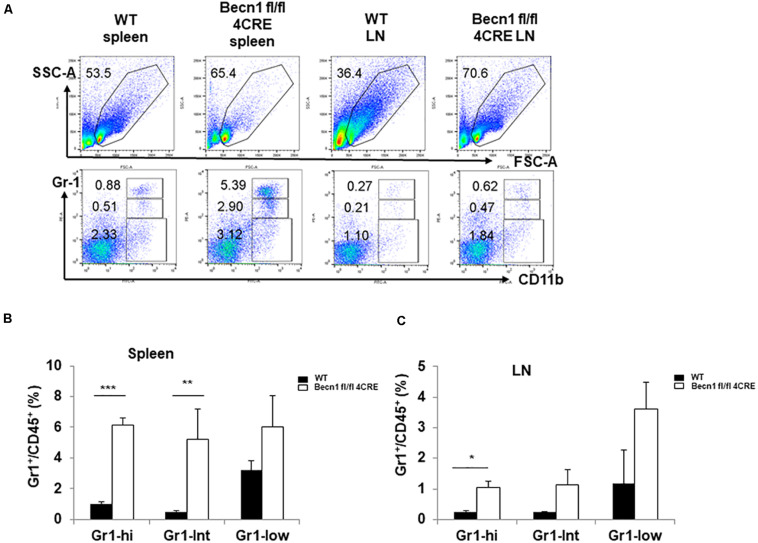
Autophagy blockade in T cells resulted in changes in innate cells. (A) The flow cytometric analysis of CD11b+ myeloid cells in spleens and lymph nodes from WT and Becn1 –/– mice. (B,C) Statistical analysis of percentages of myeloid subsets in spleens and lymph nodes from WT and Becn1 –/– mice. Data are representatives of three independent experiments. Three WT and Becn1 –/– mice were used for each experiment. Bar charts represented mean of and error bars represented SEM. *P < 0.05, **P < 0.01, ***P < 0.001 by Student’s t-test. Five WT and Becn1 –/– mice were used for each experiment. Bar charts represented mean of and error bars represented SEM. *P < 0.05 by Student’s t-test.